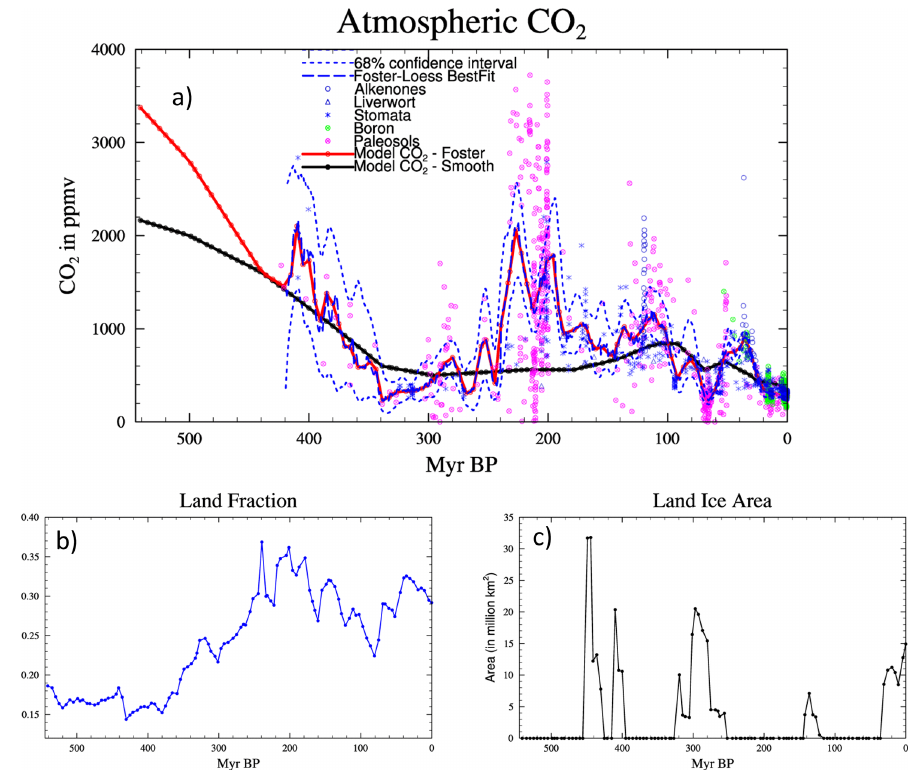
Figure 1. Summary of boundary condition changes to model of the Phanerozoic, (a) CO 2 reconstructions (from Foster et al., 2017) and the two scenarios used in the models, (b) land–sea fraction from the paleogeographic reconstructions, and (c) land ice area input into model. The paleogeographic reconstructions can be accessed at https://www.earthbyte.org/paleodem-resource-scotese-and-wright-2018/ (last access: 30 June 2021). An animation of the high-resolution (1 ◦ × 1 ◦ ) and model resolution (3.75 ◦ longitude × 2.5 ◦ latitude) maps can be found here: https://www.paleo.bristol.ac.uk/~ggpjv/scotese/scotese_raw_moll.normal_scotese_moll.normal.html (last access: 30 June 2021).